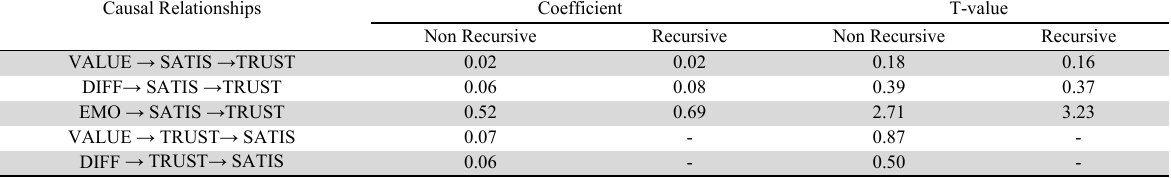
Indirect effect coefficient dan t-value in non recursive and recursive